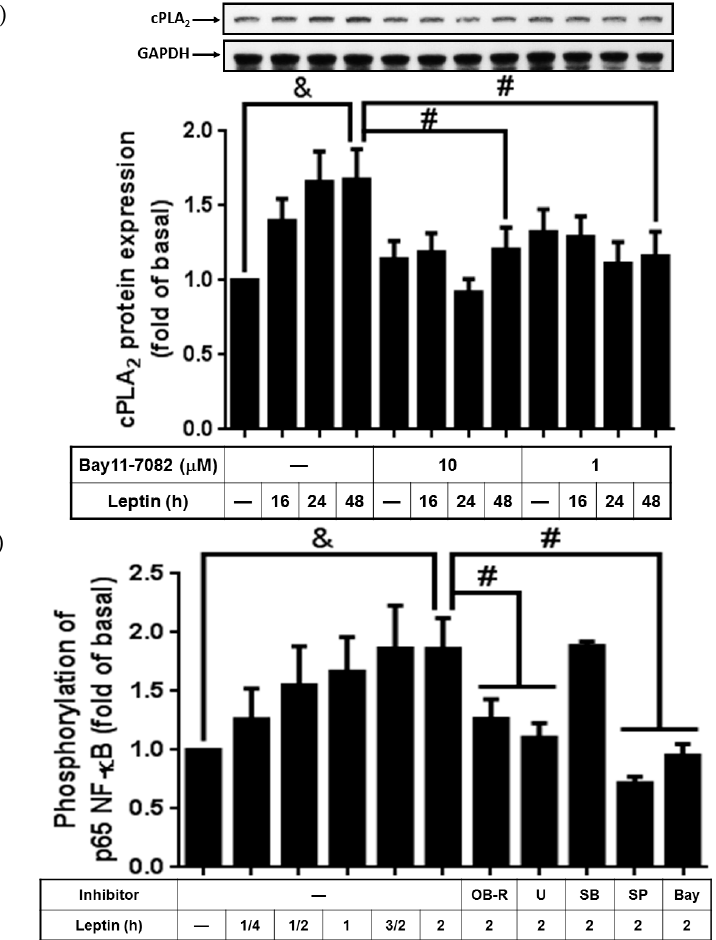
Figure 5. Effects of Bay11-7082 on leptin-regulated cPLA 2 - α expression and p65 phosphorylation. Serum-starved A549 cells were pretreated with different concentrations of Bay11-7082, OB-R (2 µg/mL), U0126 (10 µM), SB202190 (10 µM), SP600125 (10 µM), or Bay11-7082 (10 µM) for 1 h. The